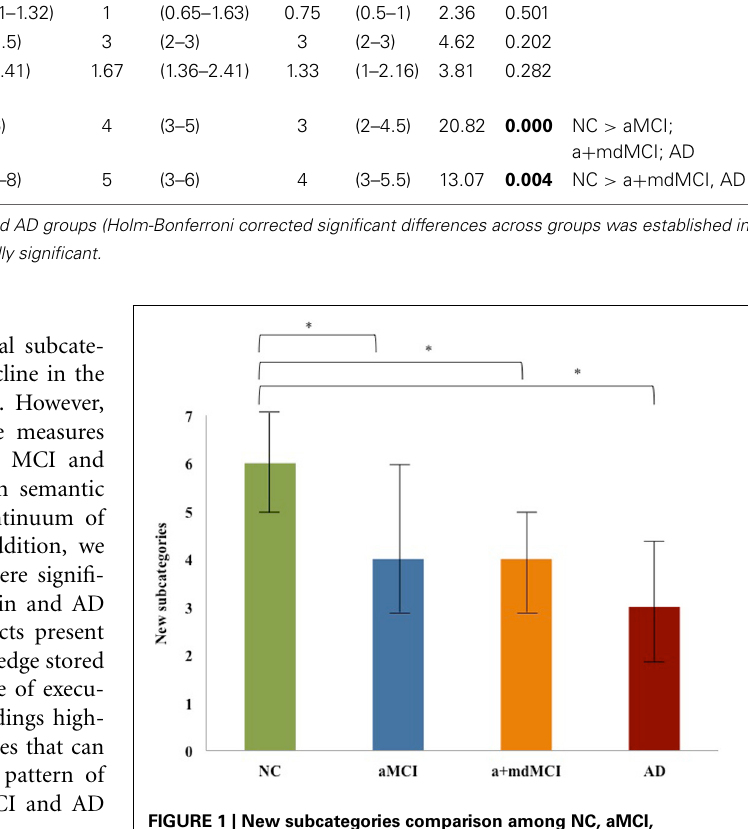
FIGURE 1 | New subcategories comparison among NC, aMCI, a-mdMCI, and AD groups. ∗ Indicates the significant ( p < 0 . 008) difference between the